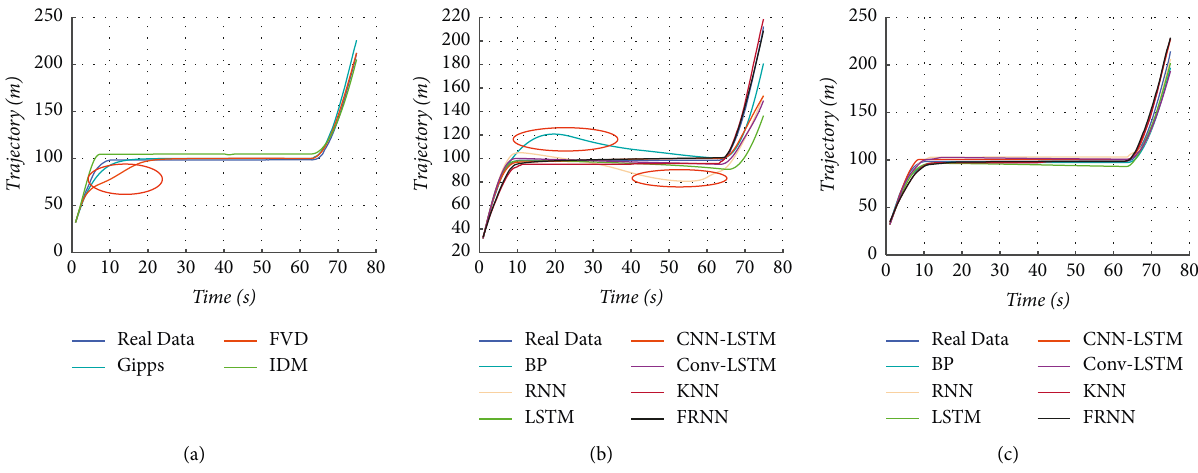
Figure 18: Trajectory comparison of discontinuous traffic flow. (a) Conventional model; (b) ANN CF-A; and (c) ANN